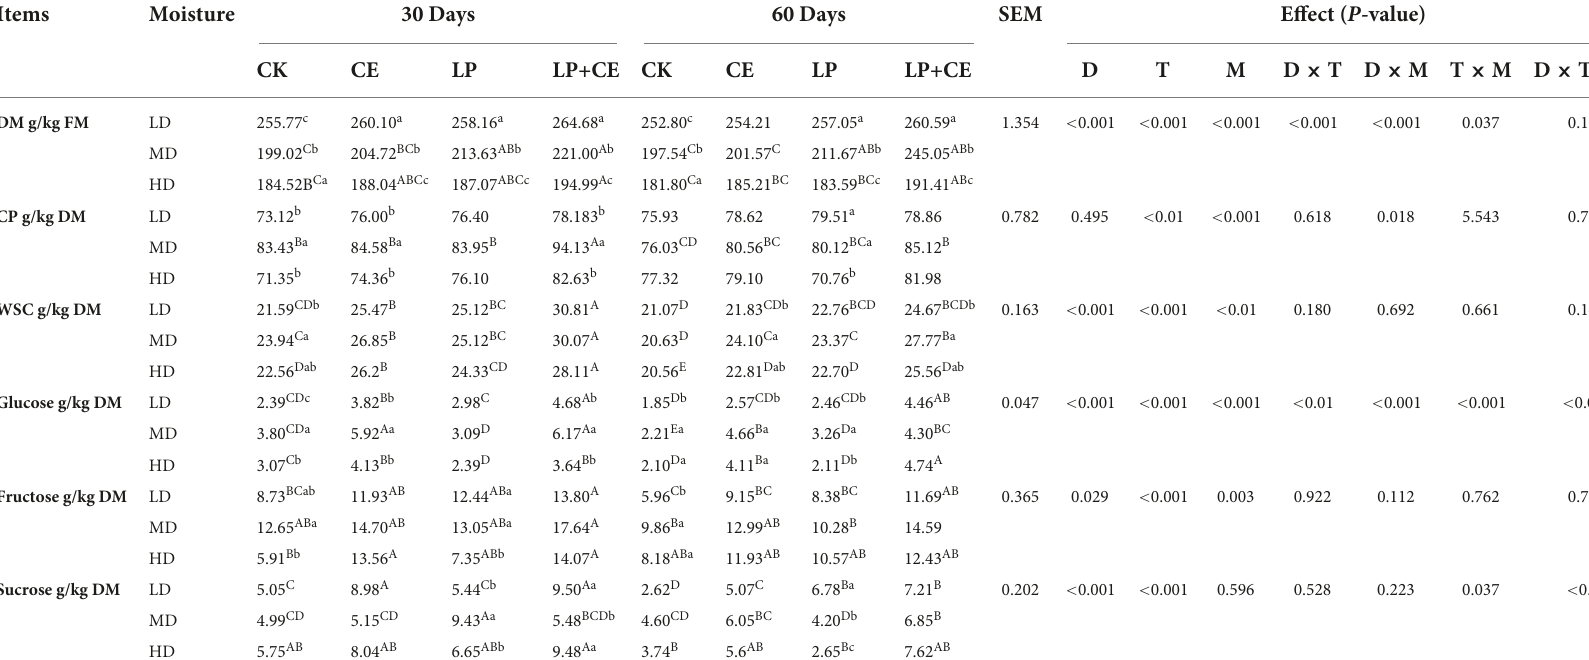
TABLE 5 Effects of the additives and moisture content on the basic nutritional quality and non-structural sugar composition of the oat silage.